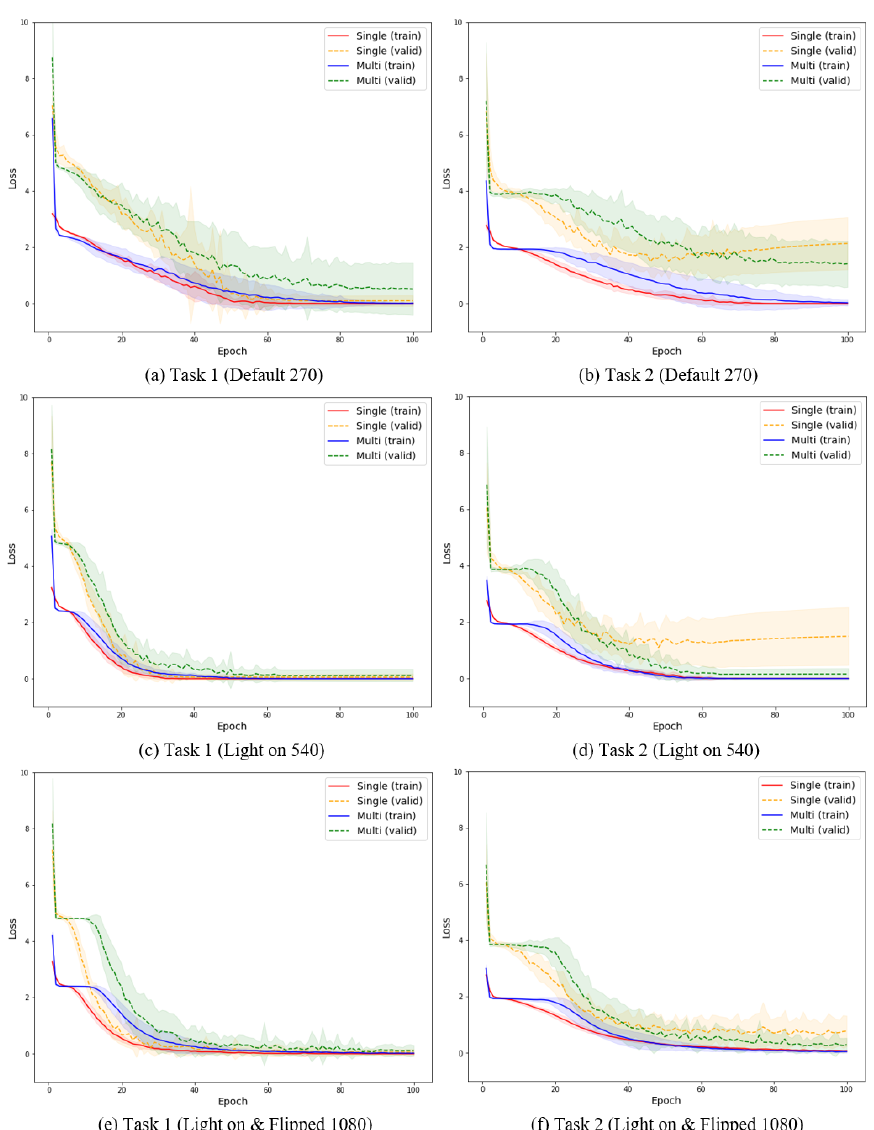
Figure 6. Illustrations of training and validation losses for ResNet-50: ( a , c , e ) are Task 1’s loss plots for different training data; ( b , d , f ) are Task 2’s loss plots for different training data. We conducted experiments with the proposed model using additional training data. ducted in four cases as shown in Tables 7 and 8 to examine the effects of each image dataset. In most cases, the additional data delivered improved performances with the most improvement associated with lighted images. The best performance was achieved when both images were